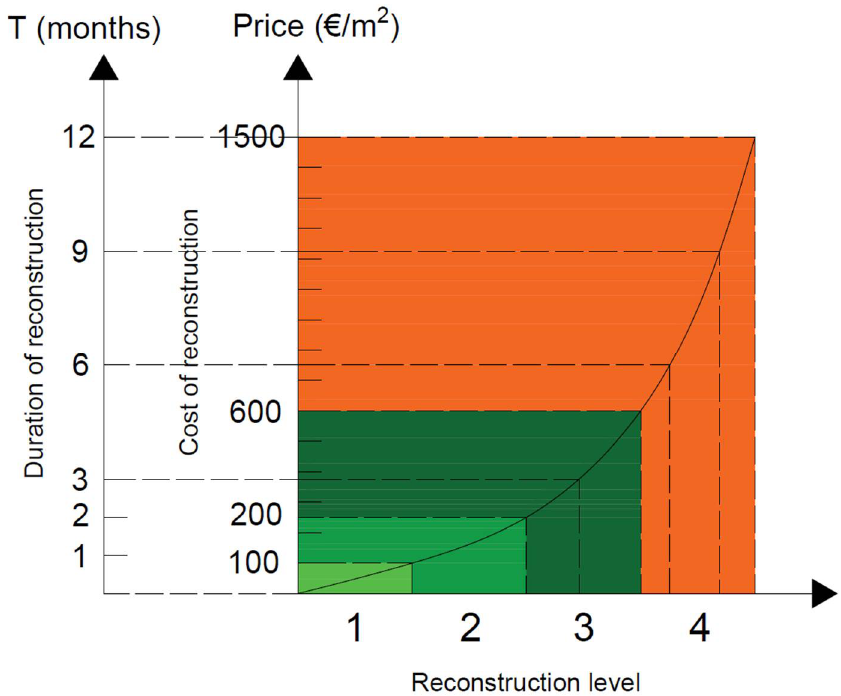
Figure 3. The relationship between the selected reconstruction level and the duration/cost of the reconstruction.